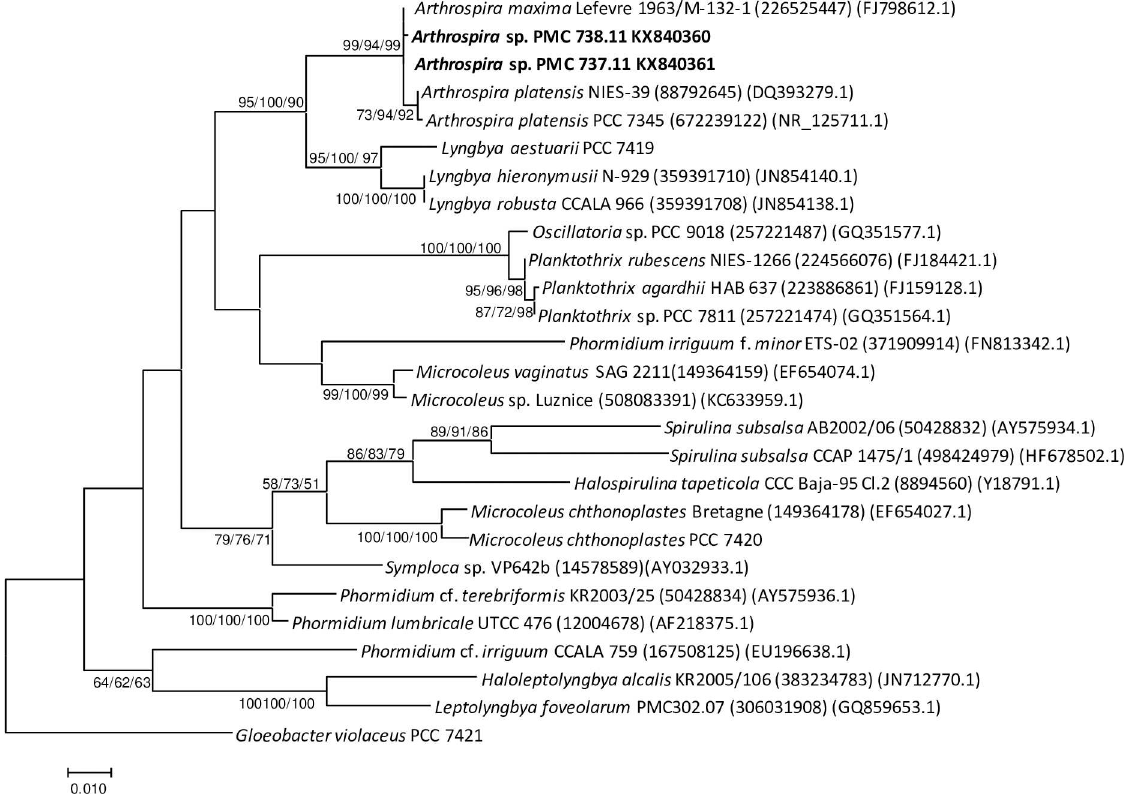
Fig 6. Consensus phylogenetic tree (maximum likelihood) constructed using 16S rRNA gene sequences (1310 bp). Clustering of Dziani Dzaha Arthrospira sp. (in bold) with related Oscillatoriales species is provided with accession number and collectioncodes. Gloeobacter violaceus PCC7421was used as outgroup.Number near nodes indicatesbootstrapvalues > 50% for neighbor joining,maximum parsimony and maximum likelihood